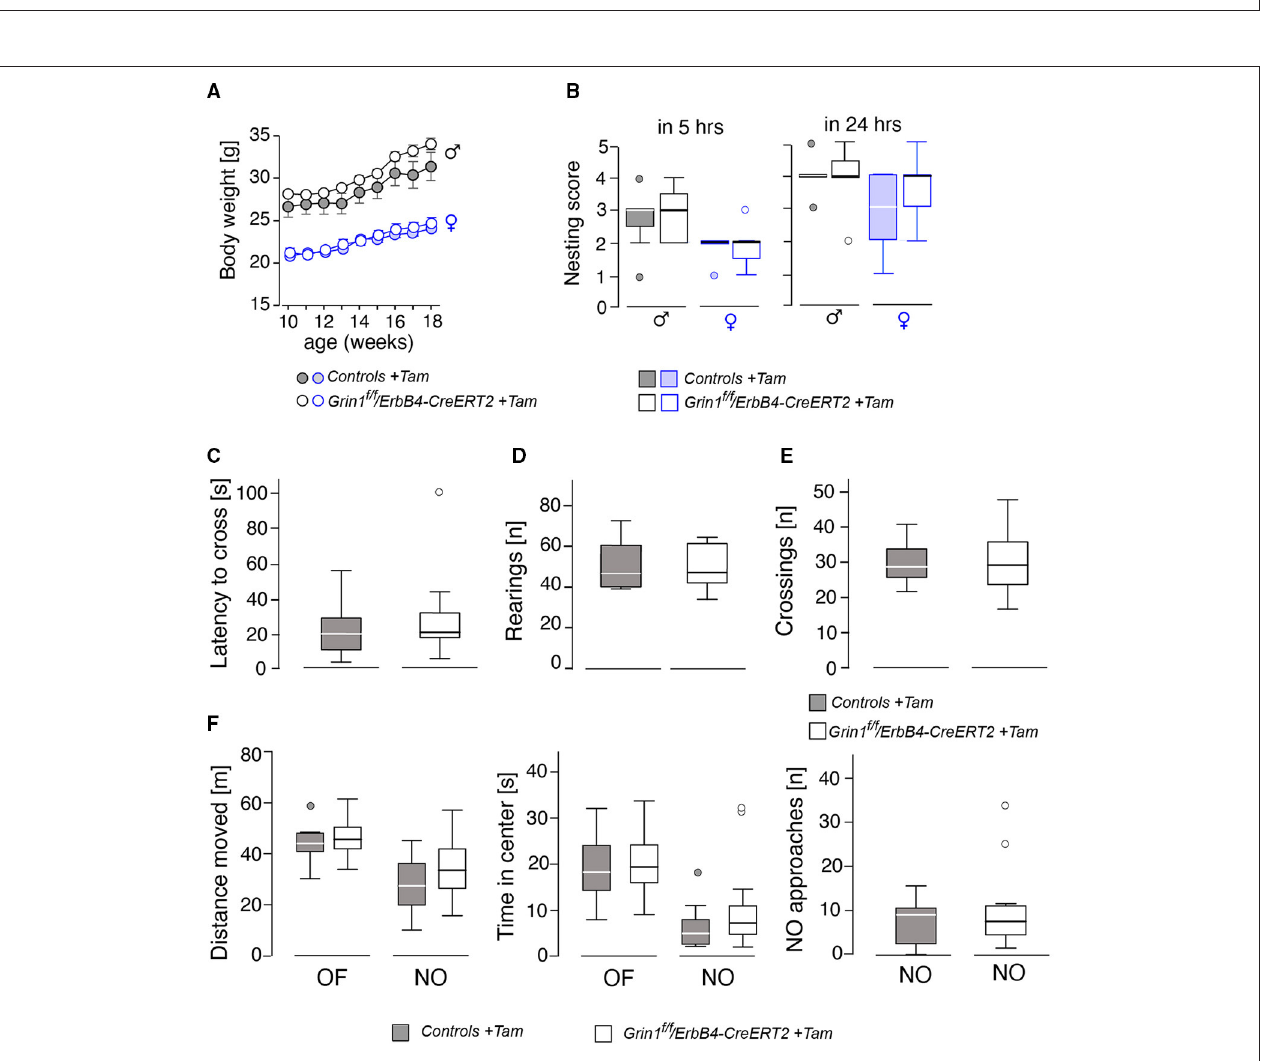
FIGURE 3 | Assessment of basic physiological and locomotor parameters in male and female mice revealed no significant effects on the genotype. (A) Body weight, (B) nest building score after 5 and 24h, (C) results of the barrier test in latency to cross the barrier, (D) number of rearings, (E) number of crossings over the barrier. In (F) the results of the open field (OF) and novel object (NO) test on gives the (left) the distance moved, (middle) time spent in center and (right) the approaches toward the novel object. Group size n = 14. Data is represented as means + SEM.